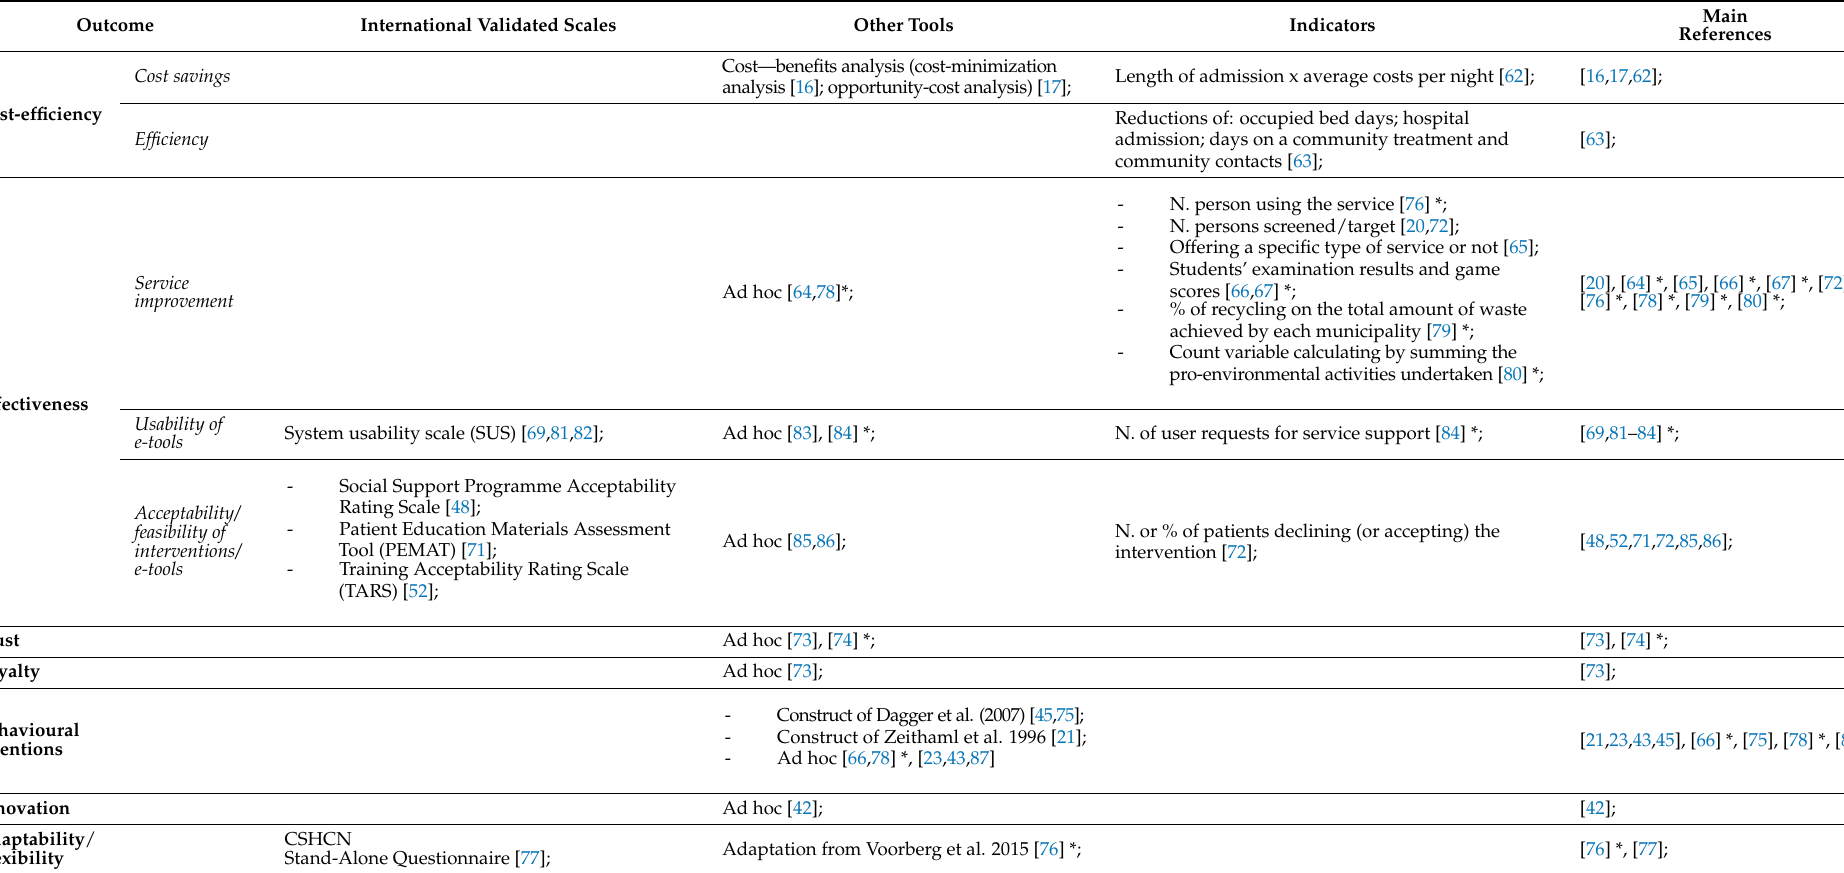
Table 6. Measures and metrics of outcomes for